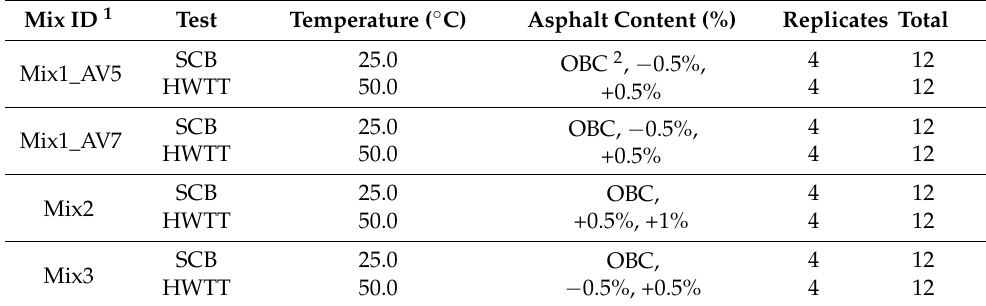
Table 2. Experimental plan for balanced mix